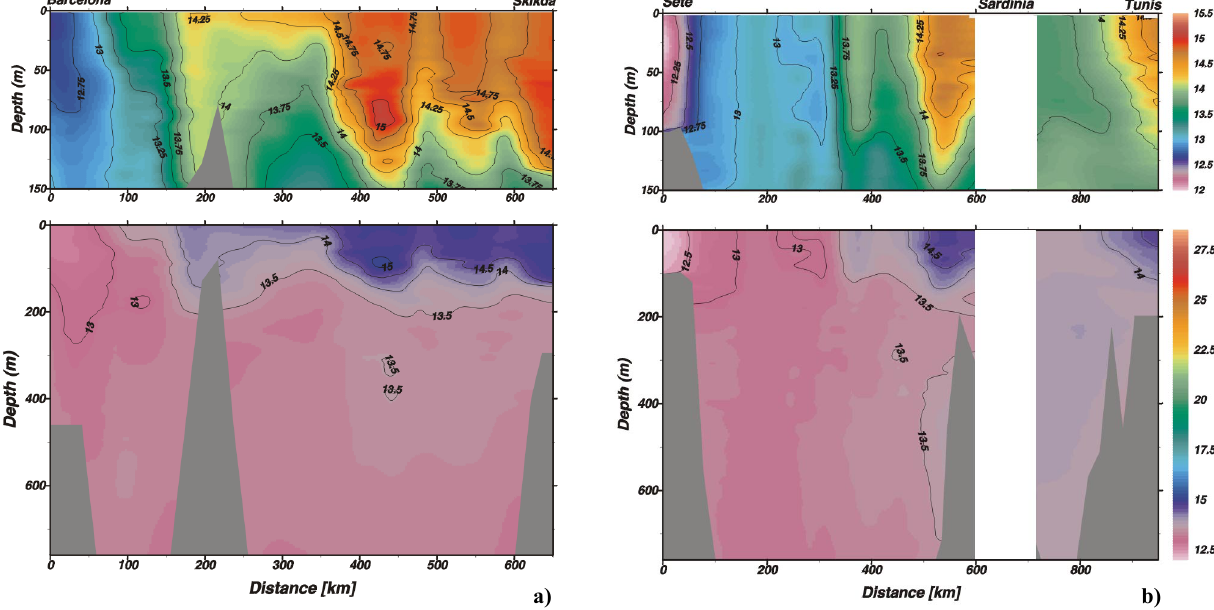
Fig. 7. Temperature vertical sections in February 2000 (a) from Barcelona to Skikda (track 2), (b) from Sete to Tunis (track